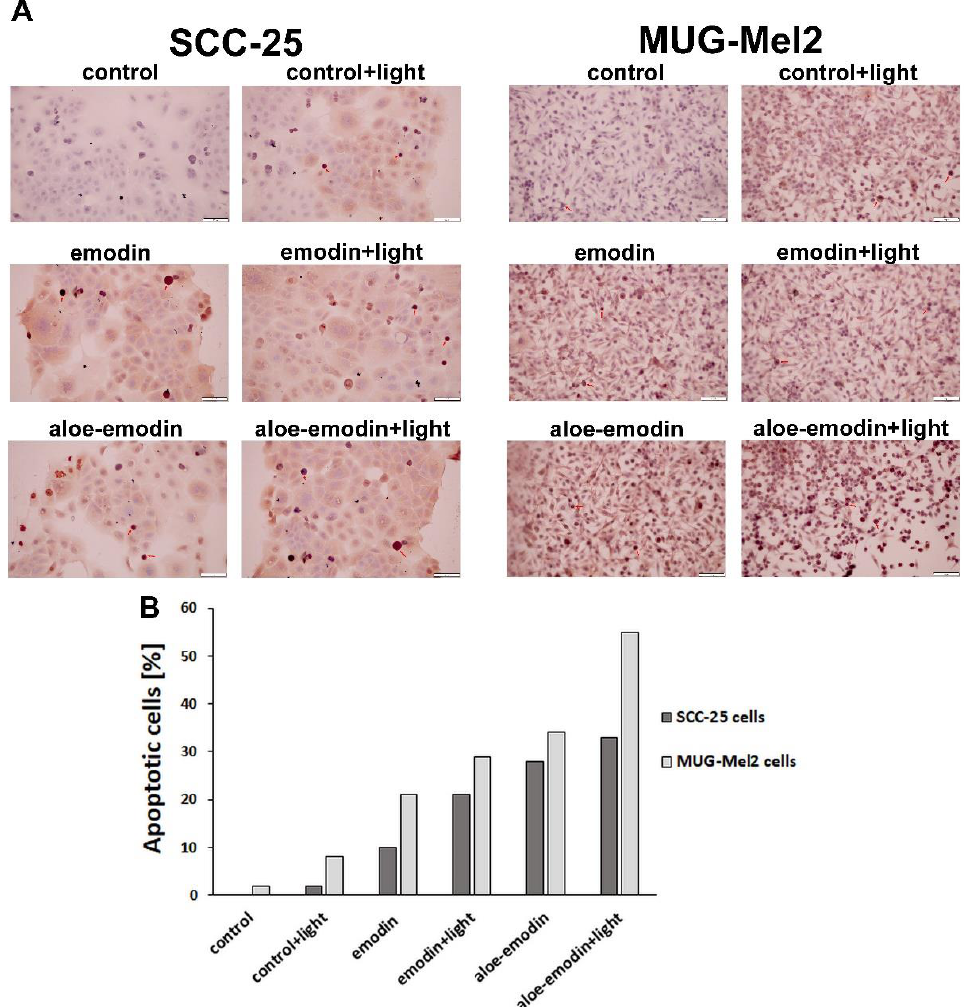
Figure 5. Results from TUNEL assay for SCC-25, and MUG-Mel2 cell line followed photodynamic therapy (PDT) with emodin or aloe-emodin at a dose of 20 µM with the blue light (6 J/cm 2 ) (A) . Diagram shows the rate of TUNEL-positive cells (peroxidase-positive) determined by dividing the number of TUNEL-positive cells by the total number of cells in the slides × 100% (B) . Scale bar = 100 µm.